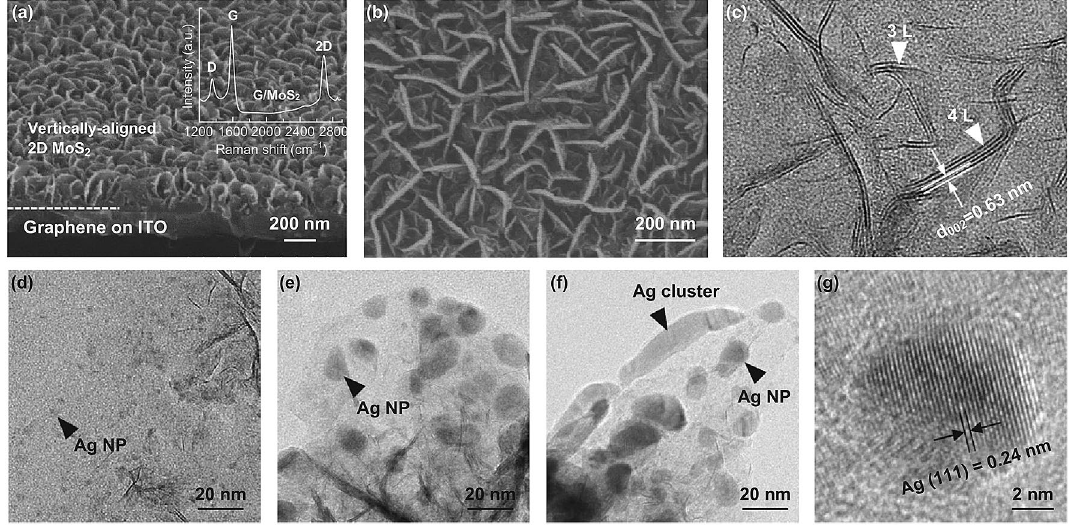
Fig. 2 a Tilted‑view SEM, b planar‑view SEM, and c planar‑view TEM images of vertically aligned MoS 2 nanosheets on graphene (G/MoS 2 ). The inset in a is the Raman spectrum of G/MoS 2 . TEM images of Ag‑decorated vertically aligned few‑layer MoS 2 nanosheets on graphene: d G/ MoS 2 /Ag‑2, e G/MoS 2 /Ag‑4, and f G/MoS 2 /Ag‑8. g High‑resolution lattice TEM image of an Ag NP in G/MoS 2